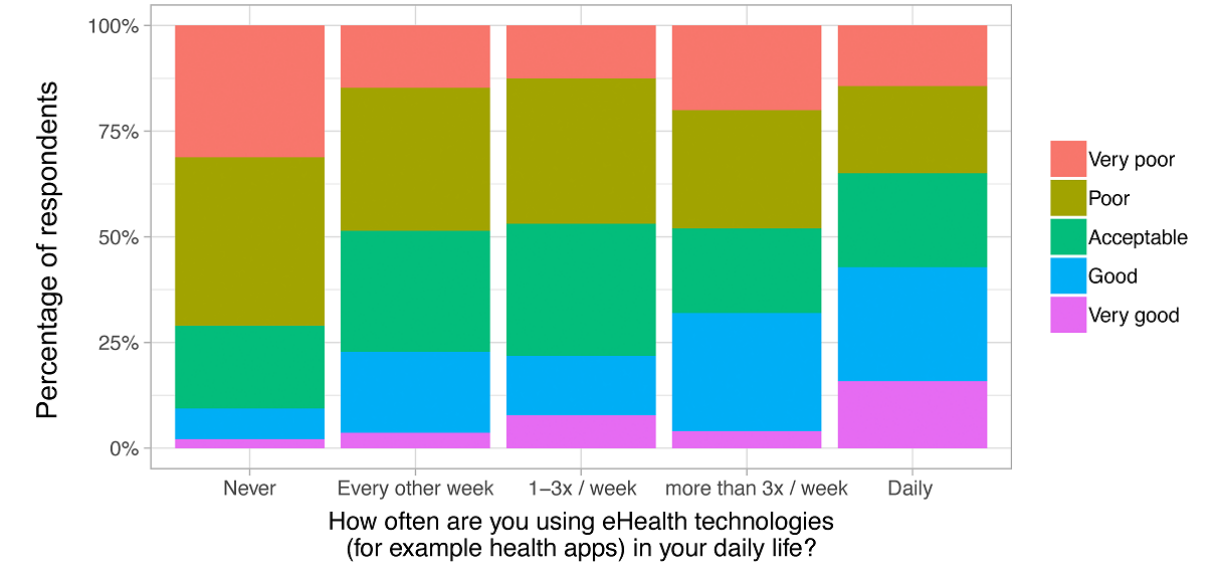
Figure 2. Self-evaluation of the respondents' eHealth skills in relation to their time spent using eHealth technologies in response to the statement: "I evaluate my eHealth skills (eg, working with clinical decision support systems, remote patient monitoring systems, artificial intelligence, applications in radiology) as...".